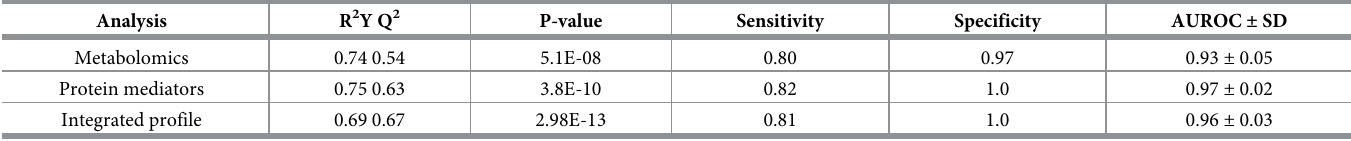
Table 2. Summary statistics from OPLS-DA models differentiating pediatric patients with and without